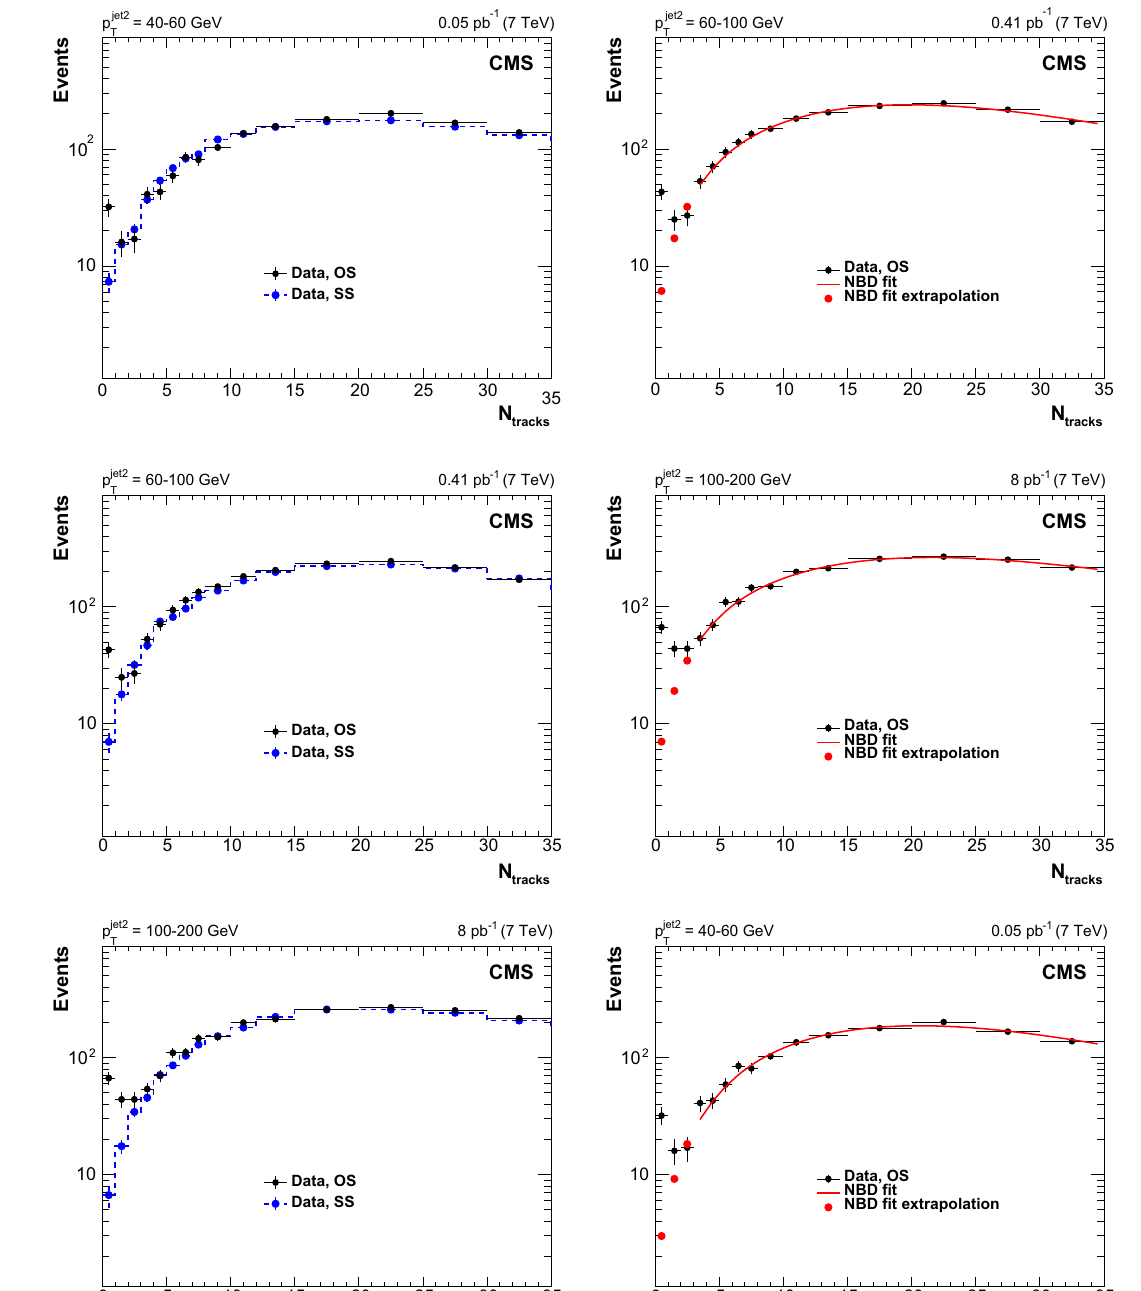
Fig. 6 Distribution, uncorrected for detector effects, of the number of centraltracksinopposite-side(OS)dijetevents(blackcircles)with p jet2 = 40–60 (top), 60–100 (middle), and 100–200 GeV (bottom), plotted